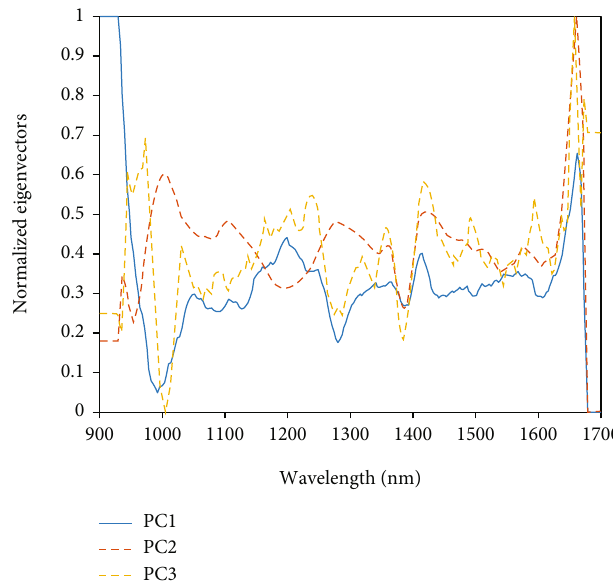
Figure 4: PCA loadings of the top three latent variables of cocoa bean